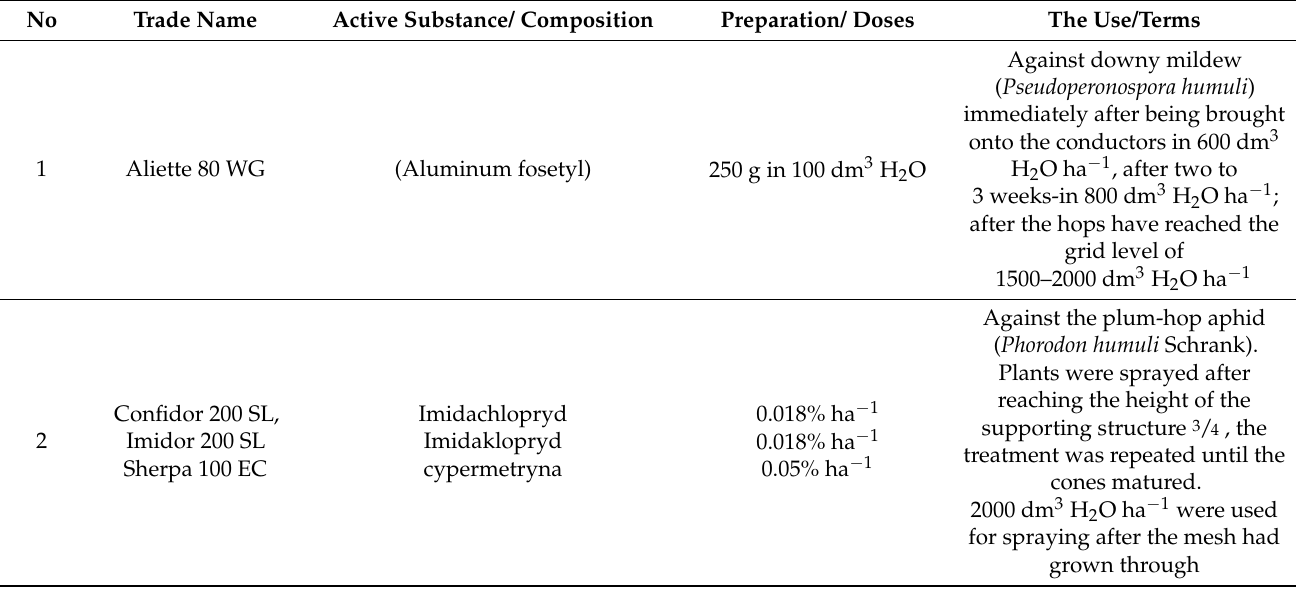
Table 3. Plant protection treatments used in the cultivation of hops (2015–2017).